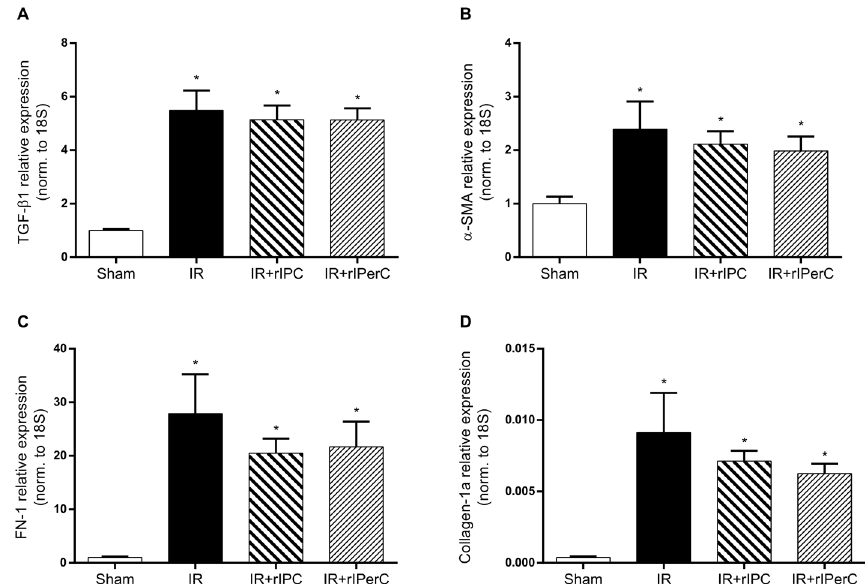
Fig 6. Effect of ischemic-reperfusion injury and remote ischemic conditioning on pro-fibrotic mediator and fibrosis marker expression. A) Transforming growth factor- β 1 (TGF- β 1). B) α -smooth muscle actin ( α -SMA). C) Fibronectin-1 (FN-1). D) Collagen-1a. Bars represent mRNA levels by quantitative polymerase chain reaction in the left renal cortex/outer medulla normalised to 18S mRNA. All values are expressed as mean ± SEM. Group means were compared using one-way analysis of variance followed by Bonferroni ’ s multiple comparison post-test. * P < 0.05 vs. sham. Number of animals: sham (n = 7, n = 5 for FN-1), ischemia-reperfusion (IR; n = 10), IR and remote ischemic preconditioning (IR+rIPC; n = 10), IR and remote ischemic perconditioning (IR+rIPerC; n =